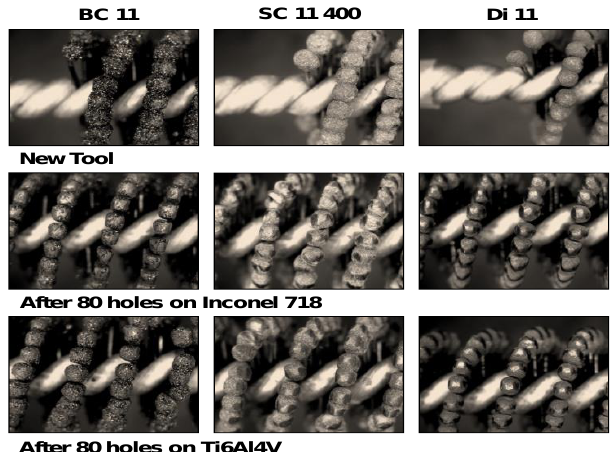
Figure 7. Tool wear on three different brushes. New tool; after Inconel 718; after Ti6Al4V (3×).